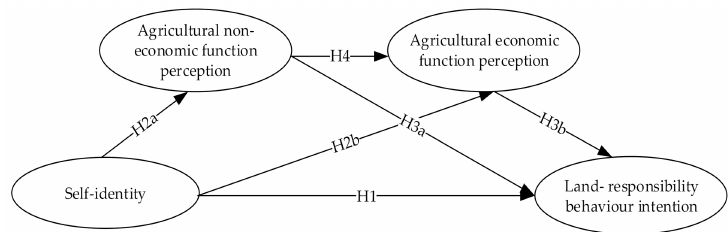
Figure 1. Research